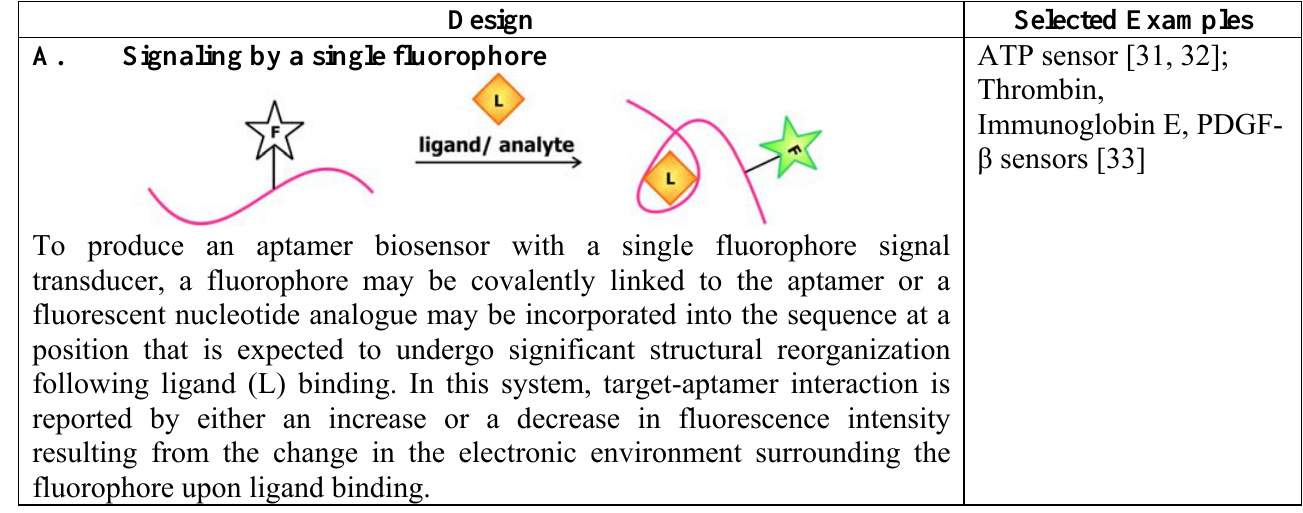
Table 1. Design strategies of fluorescence signaling aptamer